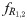
The mixing strategy for varying double resistance frequencies.We measure the fraction of incorrect treatment (A), and the rate of triple resistance emergence (B) for varying levels of double resistance to the commonly used antibiotics (fR1,2). Red curves represent the results under mixing 2 antibiotics and restricting antibiotic 3 (mix2), while green curves are the results under mixing 3 antibiotics (mix3). Dotted and solid lines are the results of the model with and without community feedback, respectively. Parameters are fR1= fR2=0.1,β=0.3, λX=0.07,p1=p2=p3=0.07
 λS=c−λX−λR1−λR2−λR3−λR1,2−λR1,3−λR2,3, and the rest are given at Table 1. The system is simulated for 20 years and other parameter values are given in the text.